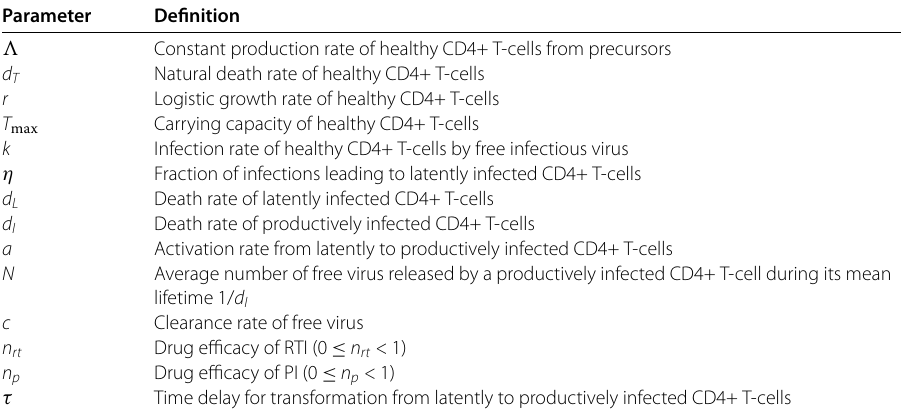
Table 2 Parameters in the model (adapted from [1, 5, 6, 15])